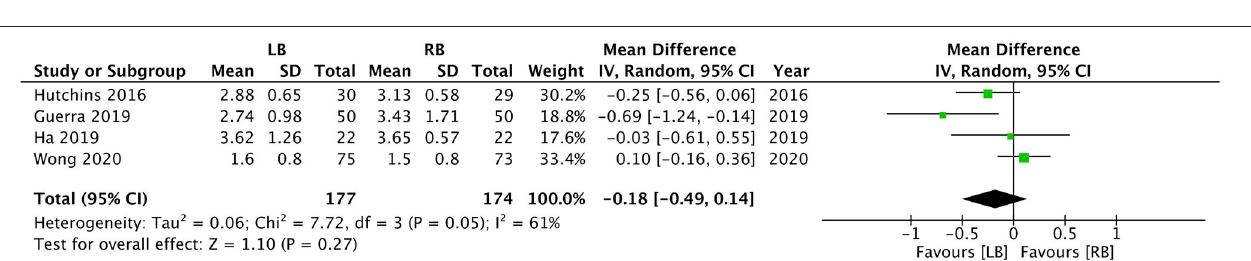
FIGURE 2 | Forest plot of pain scores for liposomal bupivacaine (LB) vs. regular bupivacaine (RB) for transverse abdominal plane (TAP) block at different time intervals.